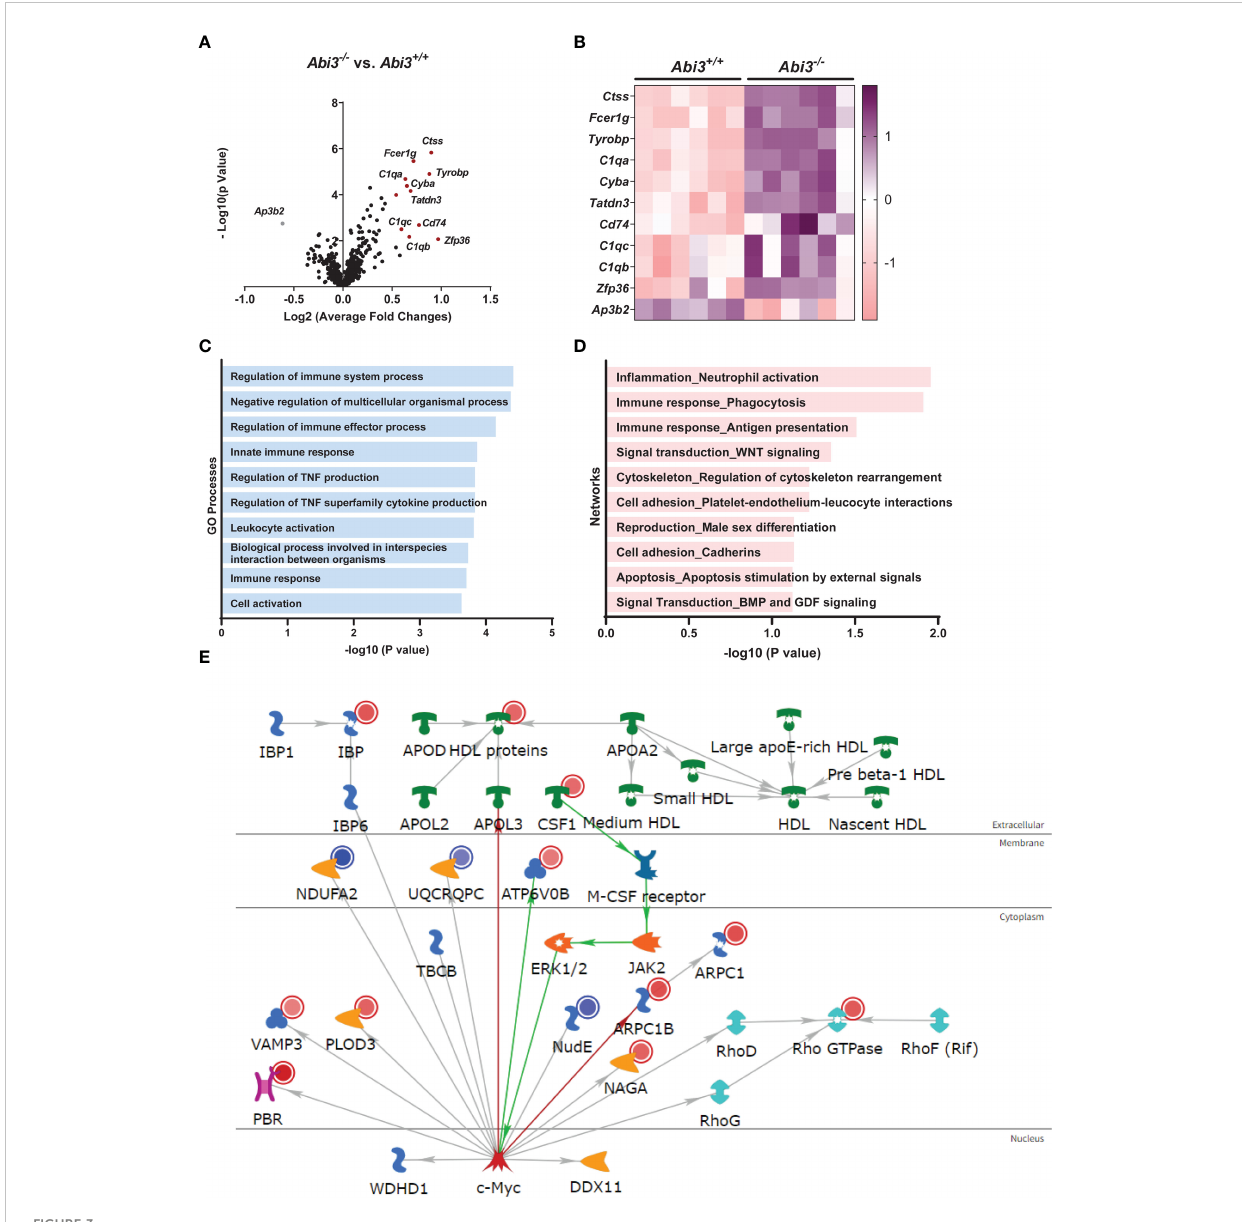
FIGURE 3 Deletion of the Abi3 locus alters immune response genes in 5XFAD mice. (A, B) Differentially expressed genes (DEGs) were identi fi ed in the cortices of 4.5-month-old Abi3 -/- mice compared to Abi3 +/+ mice using the nCounter NanoString mouse AD panel (n=6/genotype). (A) The Volcano plot demonstrates the fold change ( x -axis) and statistical signi fi cance level expressed as the − log 10 P value ( y -axis). The red dots represent genes signi fi cantly upregulated by more than 1.5-fold in Abi3 -/- mice compared to Abi3 +/+ mice. (B) The heatmap demonstrates the gene expression levels of DEGs altered by more than 1.5-fold in Abi3 -/- mice compared to Abi3 +/+ mice after z-score transformation. Upregulation is shown in purple and downregulation is in pink color. Each column represents each mouse. (C) Gene ontology (GO) and (D) Network analyses were performed for DEGs using the MetaCore ™ software. (E) Pathway analysis was performed using MetaCore ™ . Upregulated genes in our dataset are shown with red circles and downregulated genes are shown with blue circles in the pathmap. Green arrows between nodes represent activation, while grey arrows represent interaction with no speci fi c direction of effect. See also Supplementary Tables 1-3 and Supplementary Figure